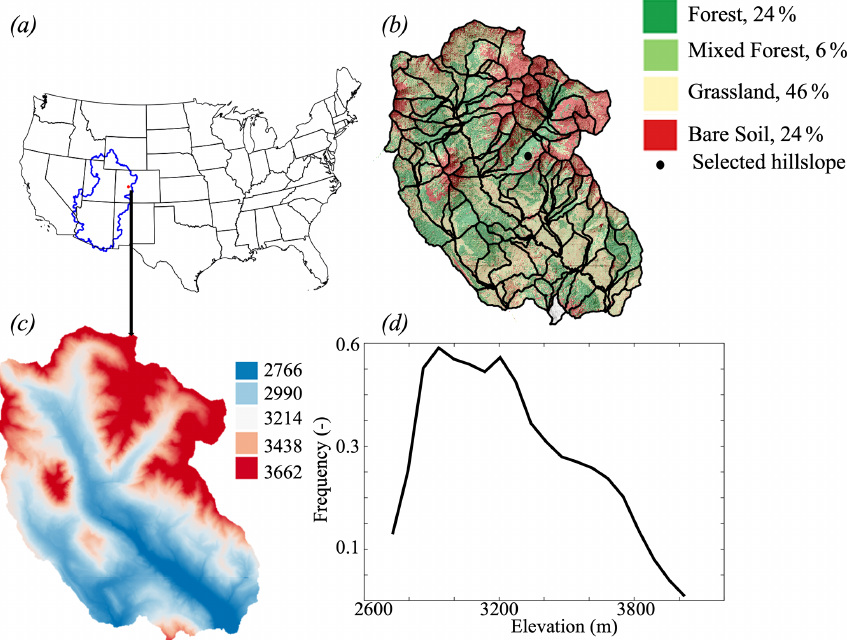
Figure 1. (a) Location of the East River watershed, (b) land cover (NEON data set, 2020), (c) lidar digital elevation, and (d) elevation distribution within the East